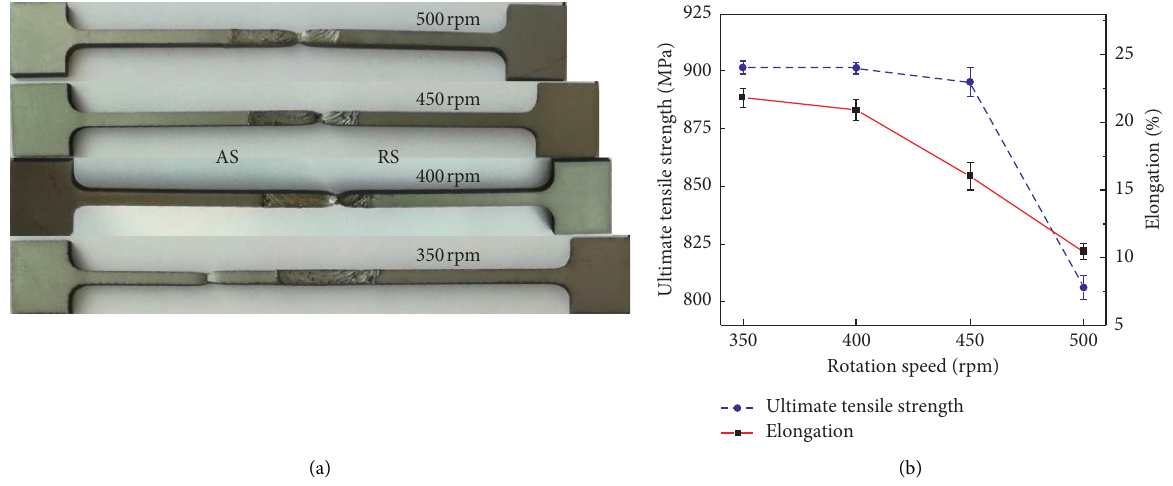
Figure 14: (a) The macrographs of the tensile samples after fracture. (b) Recorded tensile strength and the percentage elongation after fracture of the tensile samples change with rotation